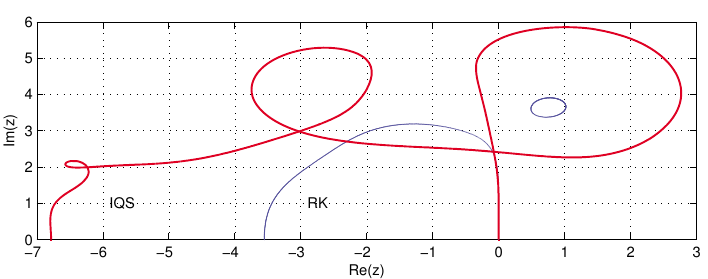
In Fig. 10 we have plotted the stability region of this method and of an approximation of order 6 of the function exp( z